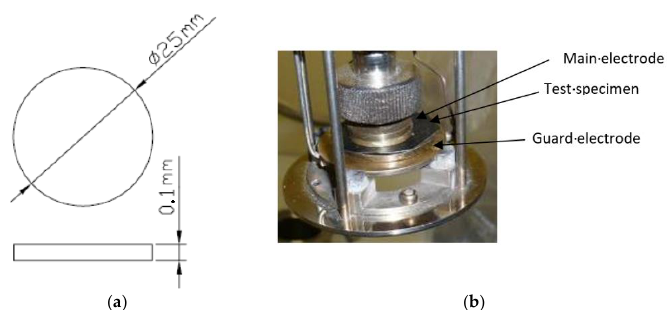
Figure 2. Samples for Dynamic Electric Analysis (DEA) used. ( a ) Specimen dimensions; ( b ) DEA electrodes with composite